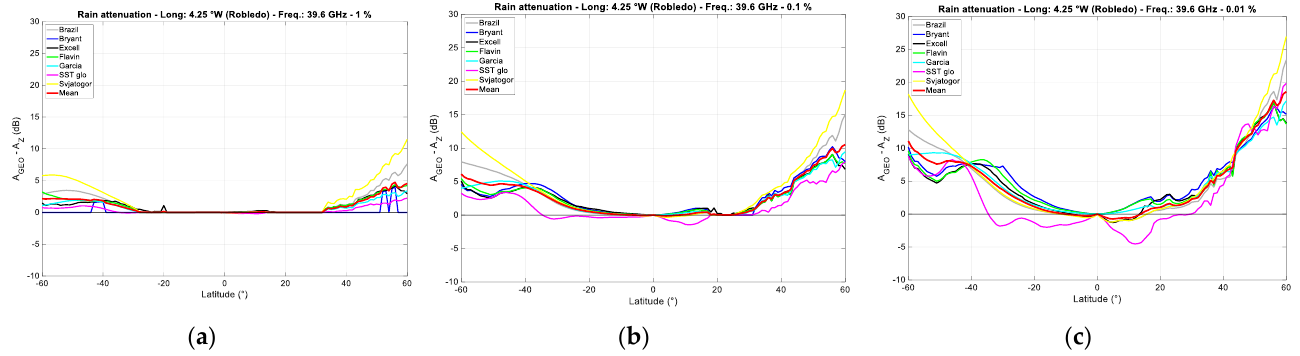
Figure 4. The difference A GEO − A Z , calculated at fixed annual probabilities 1% ( a ), 0.1% ( b ), and 0.01% ( c ), between the rain attenuation exceeded in the GEO path, A GEO , and the rain attenuation exceeded in the GeoSurf path, A Z , i.e., at the zenith in Robledo; 39.6 GHz, circular polarization.